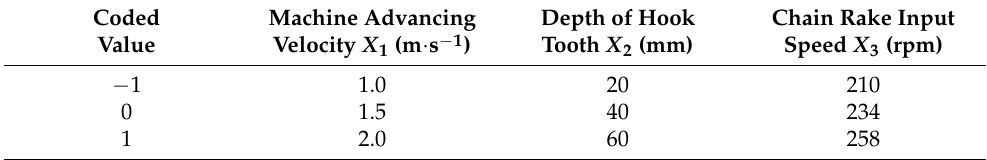
Table 2. The test factors and levels.